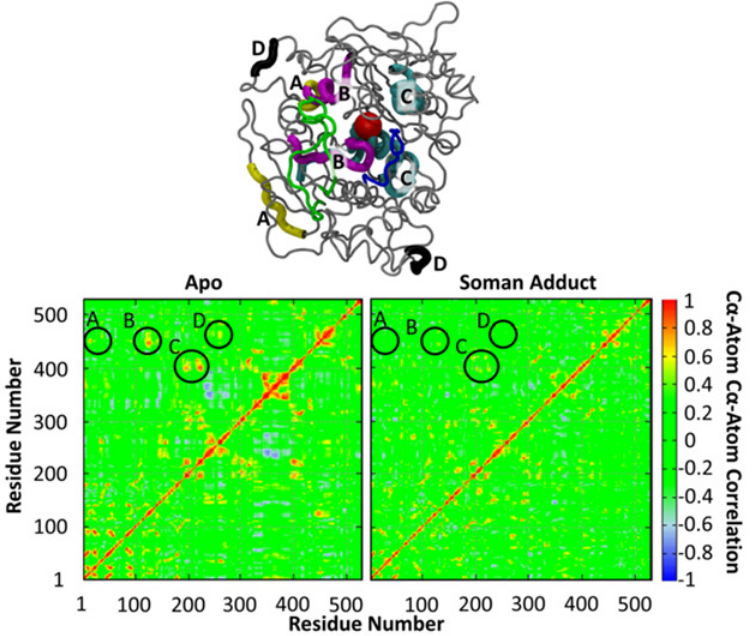
Fig 13. Normalized correlation matrices of the main chain C α atoms in the apo and soman-adducted AChE. A backbone representation of the apo ache is shown (top) highlighting the circled regions (bottom); (A) residues 15 – 20 and 450 – 455, (B) residues 120 – 130 and 445 – 452, (C) residues 190 – 220 and 400 – 410, (D) residues 262 – 265 and 464 –